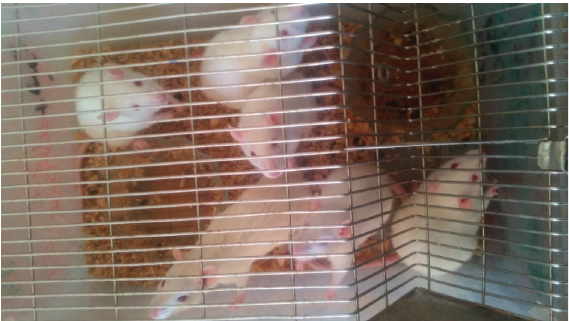
Figure 1: Experimental male albino